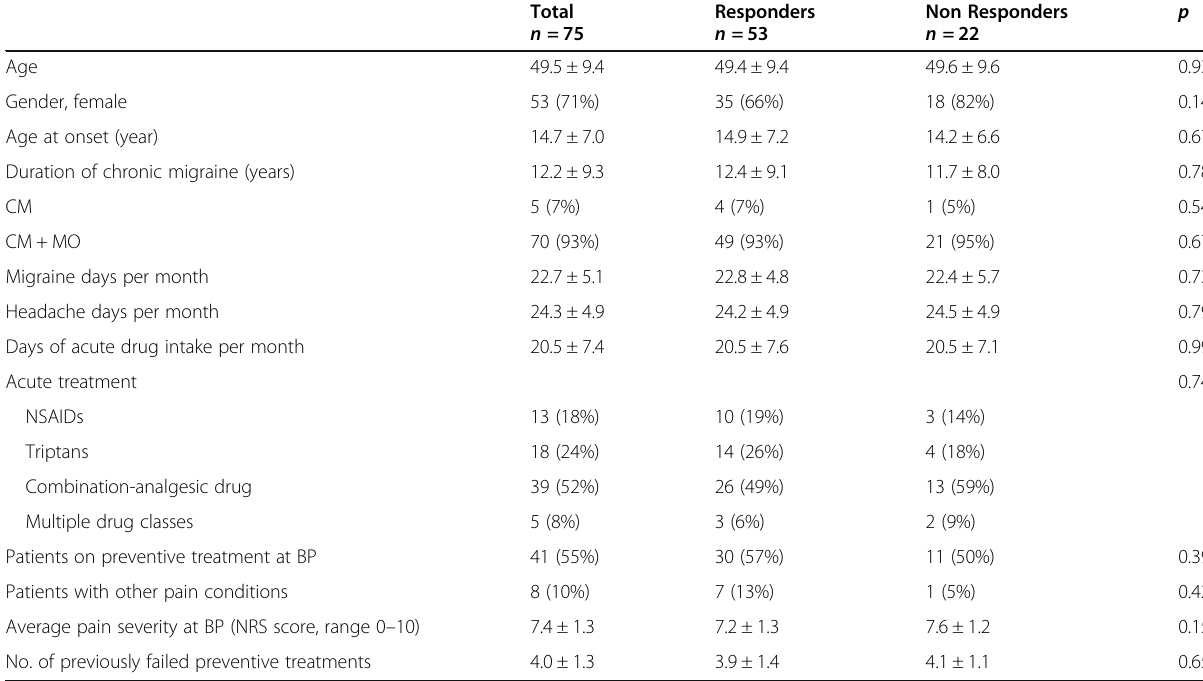
Table 1 Baseline clinical characteristics of study population. Data are presented as “ mean ± standard deviation ” or “ absolute value